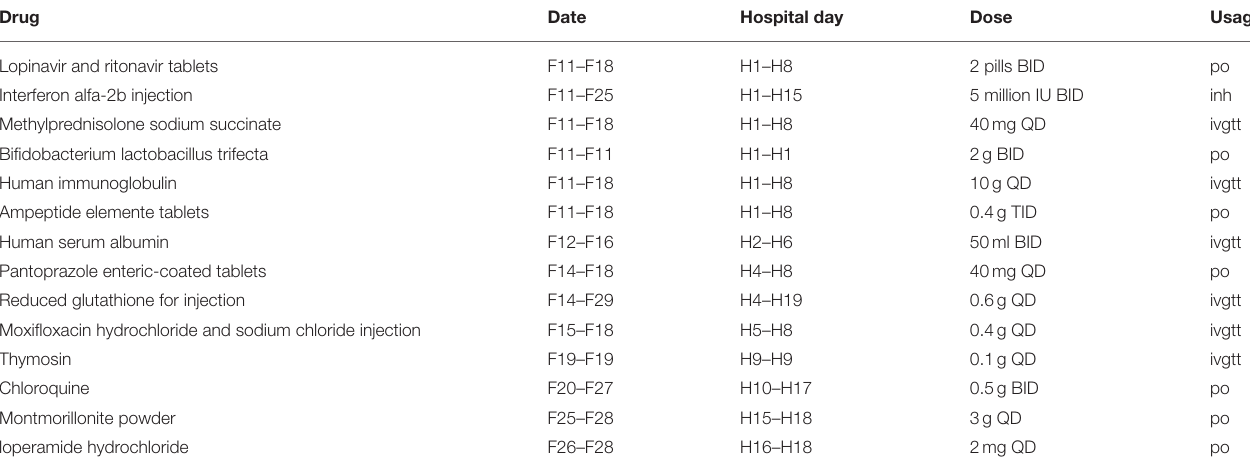
TABLE 3 | Order sheet of the